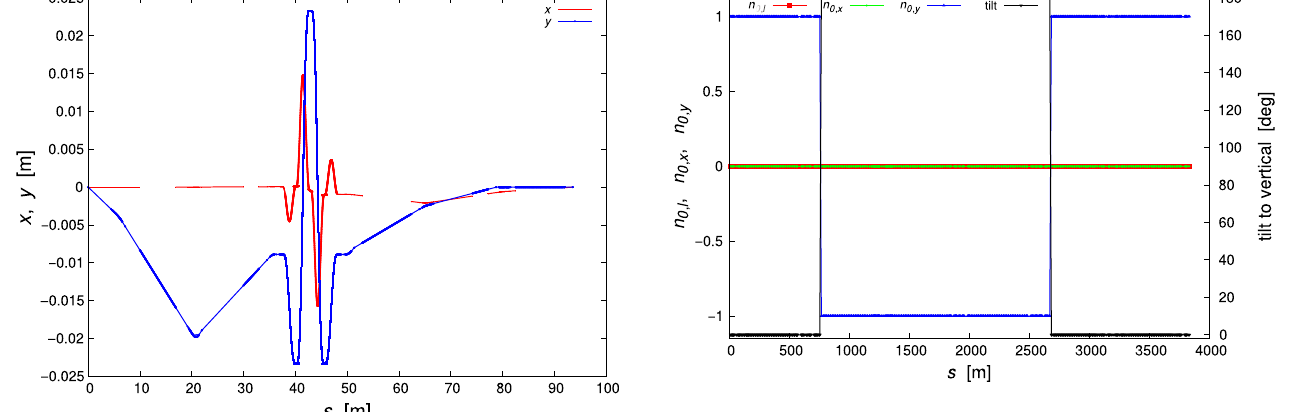
FIG. 14. Spin ⃗ n 0 vector around Yellow ring and tilt angle. Case of snake field maps offset, thus no orbit bumps, with helix ¼ 93 . 35 A, I ¼ 321 . 87 A. Spin closed orbit is currents I out in vertical around the ring.